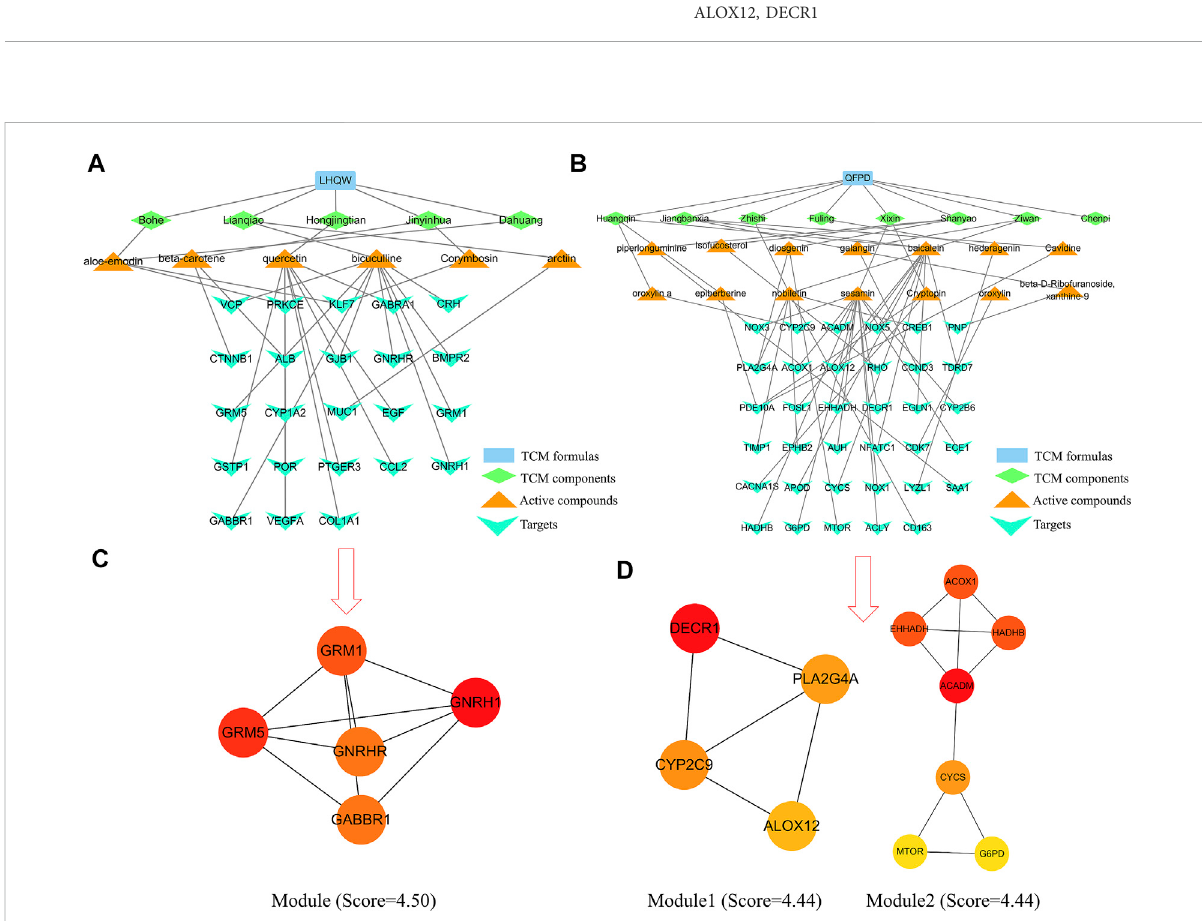
FIGURE 4 “ TCM component – active compound – speci fi c target ” networks and protein modules of LHQW and QFPD. The green diamond represents the TCM components, the orange triangle represents the active compounds, and the cyan fusiform represents the network targets. (A) Interconnection between TCM components, active compounds, and the speci fi c targets of the active compounds in LHQW. (B) Interconnection between TCM components, active compounds, and their speci fi c targets of the active compounds in QFPD. (C) The signi fi cant module identi fi ed from